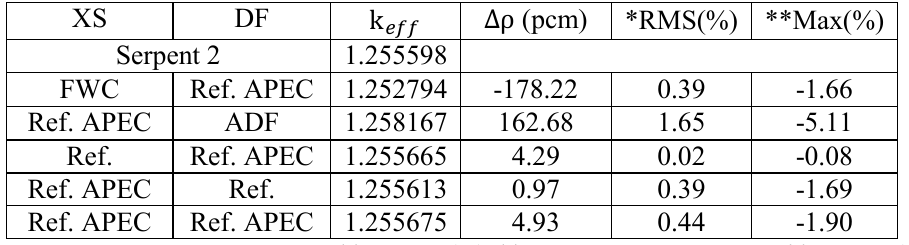
Table Ⅱ . Application of reference APEC XS and DF functions.